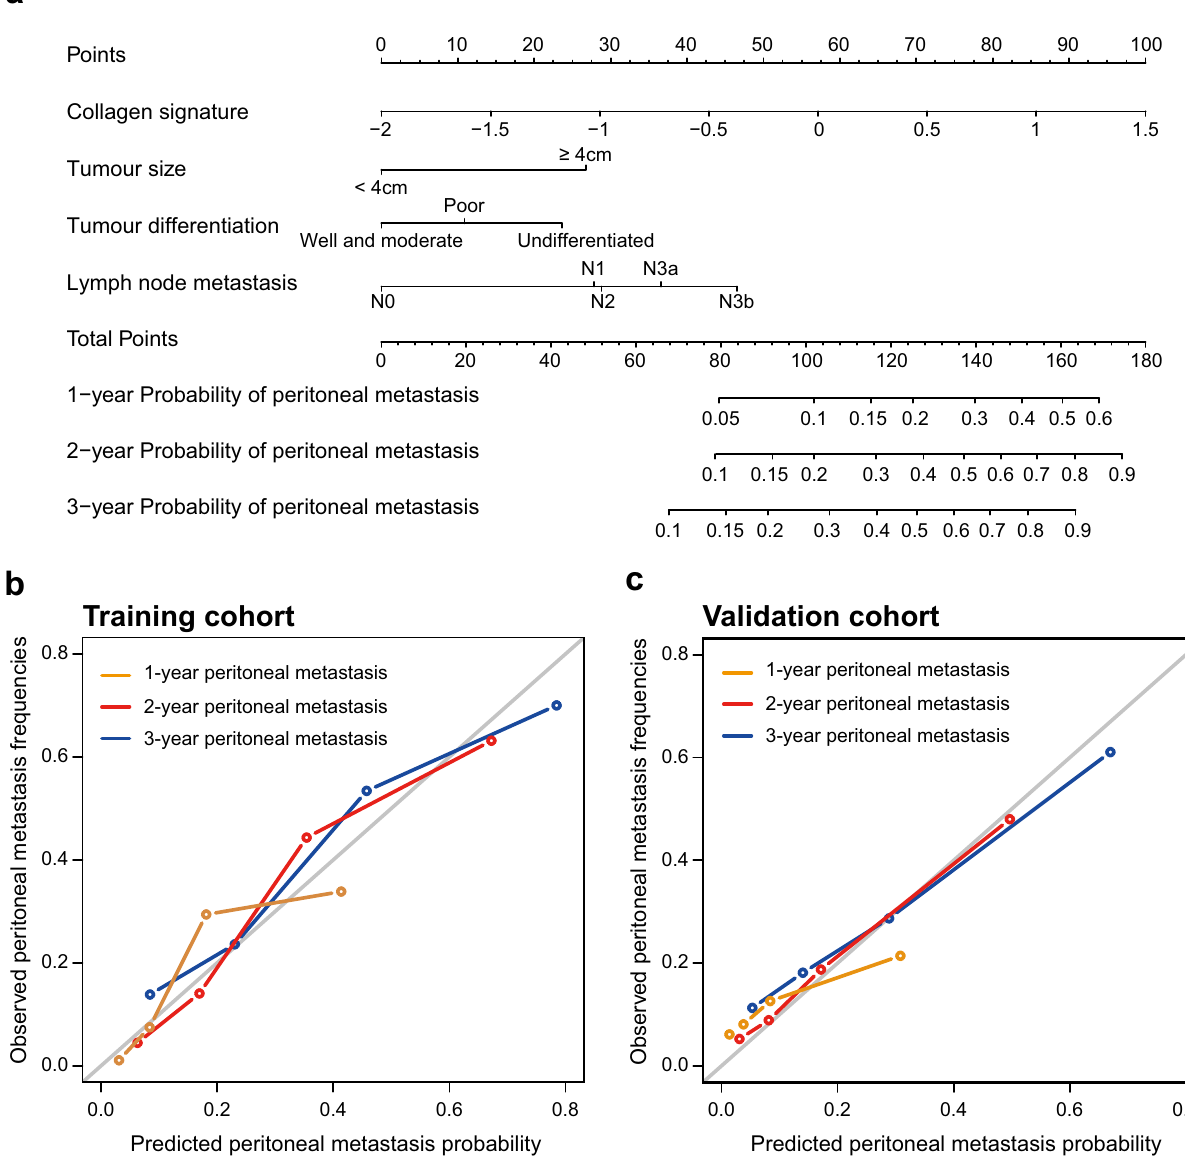
Fig. 4 Competing-risk nomogram and the corresponding calibration curve. a Competing-risk nomogram incorporating the collagen signature, tumour size, tumour differentiation and lymph node metastasis. b Calibration curve of the competing-risk nomogram in the training cohort. c Calibration curve of the competing-risk nomogram in the validation